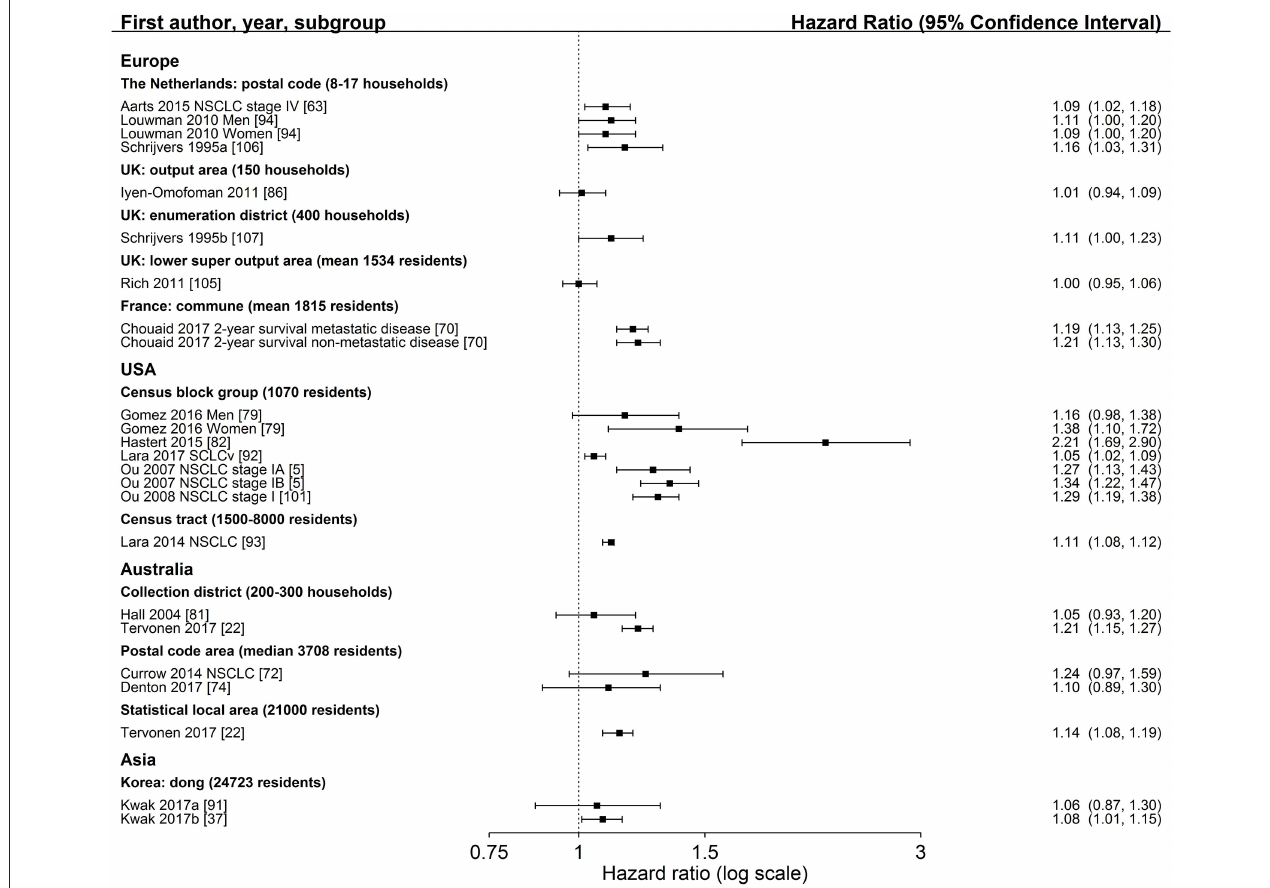
FIGURE 5 | Association of area-based index measures (reference: high socioeconomic group) and survival after lung cancer. Order: region and small to large area level. NSCLC, non-small cell lung cancer; SCLC, small cell lung cancer; UK, United